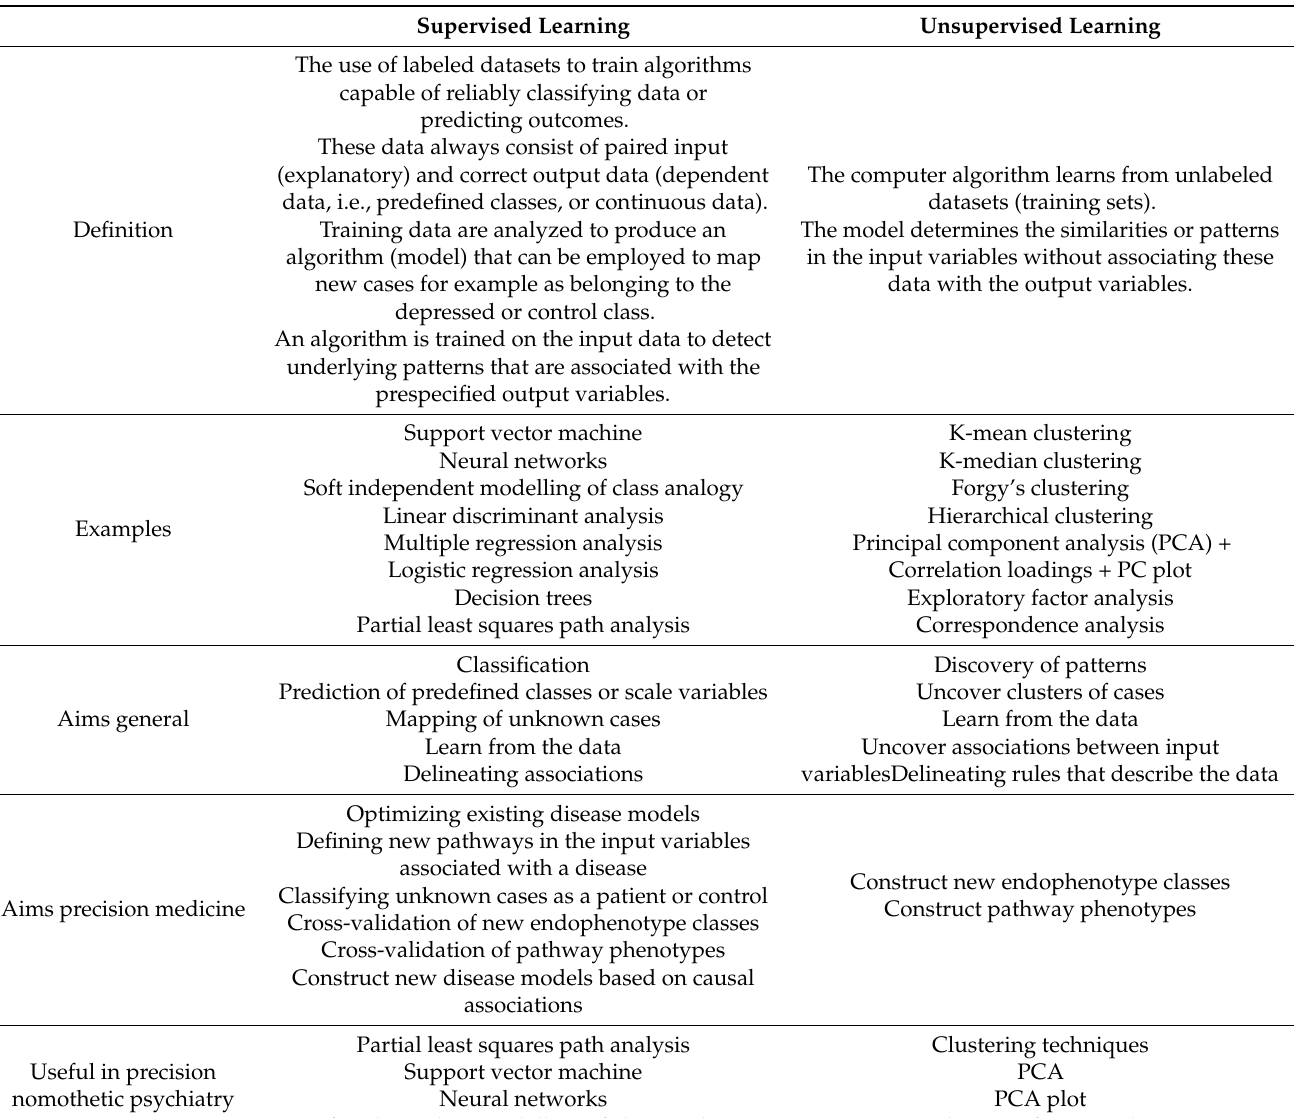
Table 1. Supervised and unsupervised pattern recognition methods useful in precision